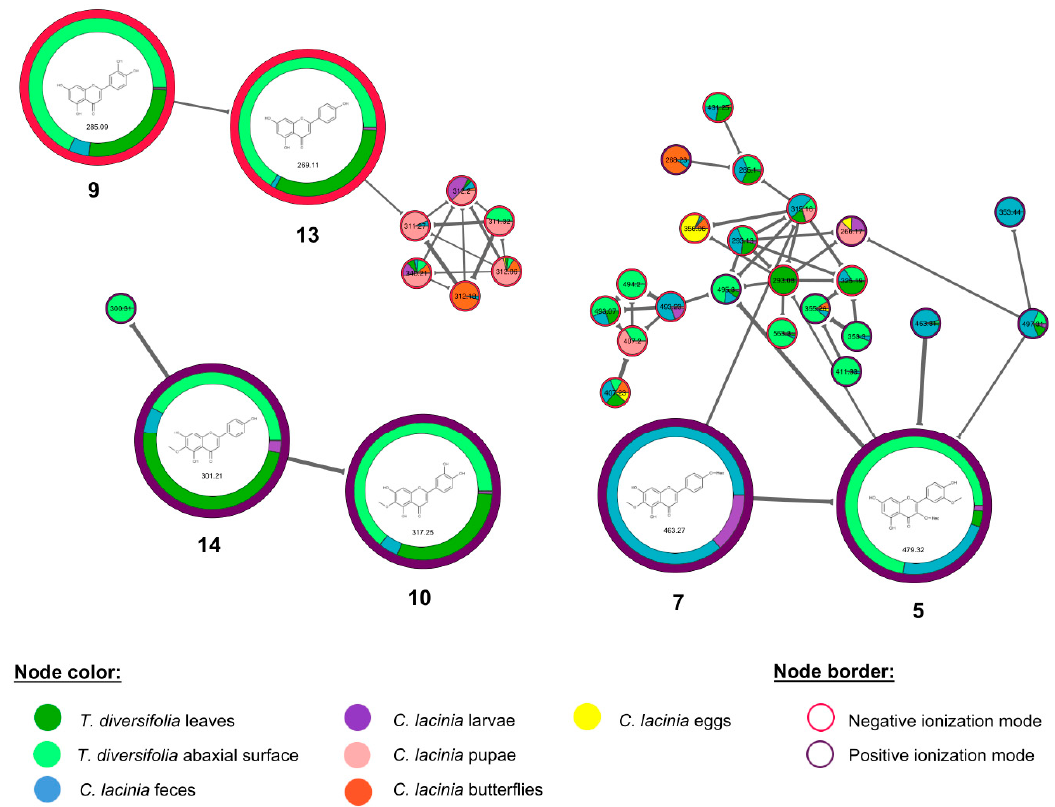
Figure 4. Molecular networking highlighting the cluster of annotated flavonoids. Nodes are colored according to the type of sample. Borders of the nodes are colored according to the ionization mode in which the mass feature was obtained.